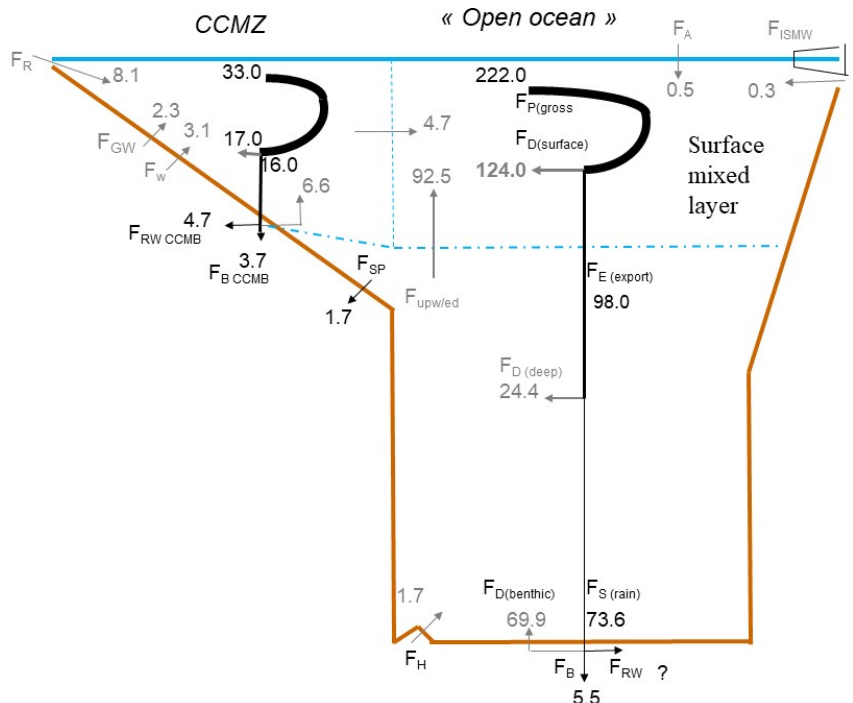
Figure 4. Schematic view of the Si cycle in the coastal and continental margin zone (CCMZ), linked to the rest of the world ocean (open-ocean zone, including upwelling and polar zones). In this steady-state scenario, consistent with Fig. 1, total inputs = total outputs = 15 . 6Tmol Siyr − 1 . This figure illustrates the links between biological, burial, and reverse weathering fluxes. It also shows that the open-ocean bSi (pelagic) production ( F P(gross) = 222Tmol Siyr − 1 ) is mostly fueled by dSi inputs from below 92.5Tmol Siyr − 1 , with the CCMZ only providing 4.7Tmol Siyr − 1 to the open